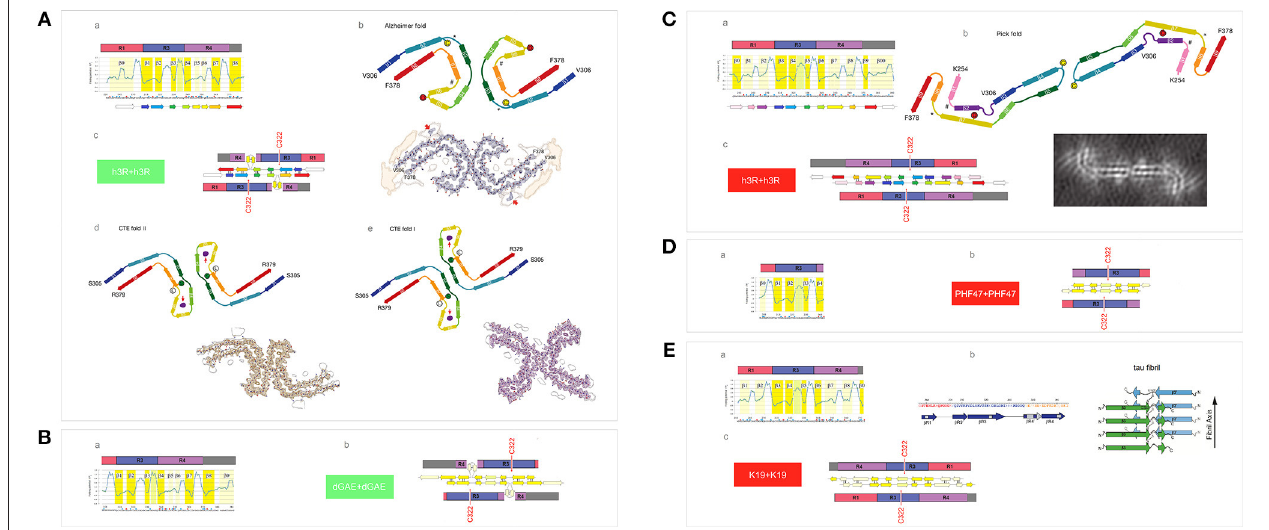
FIGURE 7 | Electronic configuration of the polypeptide backbone and divergent pathways of fibrillization of 3R isoforms: tau inclusions in Alzheimer’s, CTE and Pick’s disease. (A) (a) The FP i profile of the tau repeat domain 3R (R1-R3R4), calculated with σ His = − 0.2917, indicates “C 5 strand” propensity of the